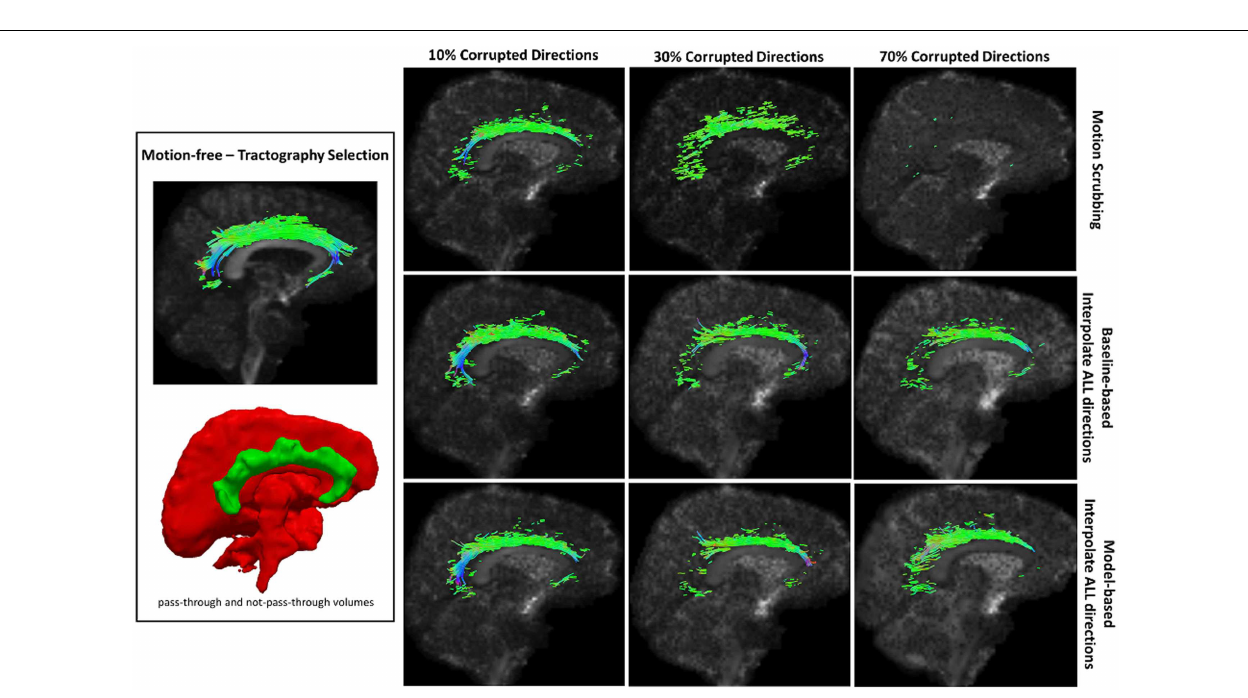
FIGURE 8 | Sample tractography selection for the corpus callosum (CC) from the untilted motion-free dataset as well as selections from motion-corrected datasets with 10, 30, and 70% corrupted gradient directions . Correction choices shown include outlier-based (i.e., motion